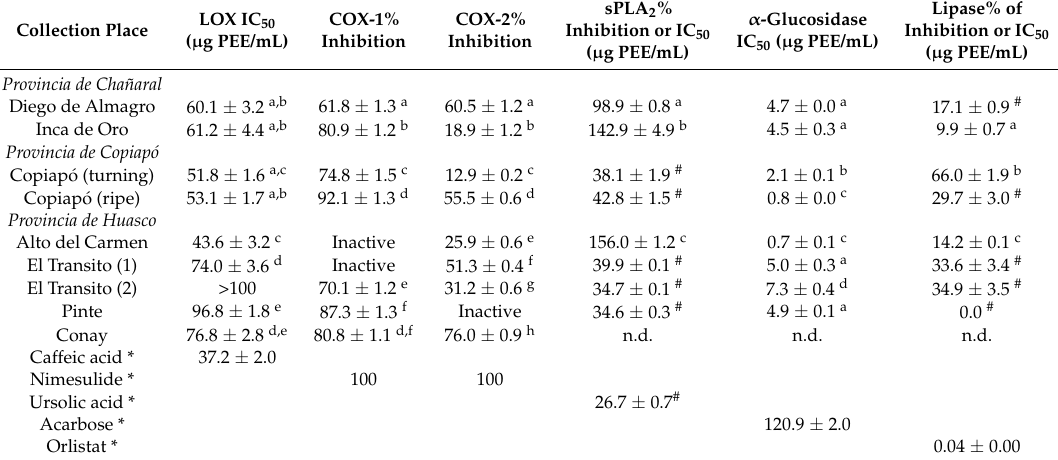
Table 2. Inhibition of the pro-inflammatory enzymes (LOX, COX-1/COX-2 and sPLA 2 ) and metabolic syndrome-associated enzymes ( α -glucosidase and lipase) by G. decorticans fruit PEEs. Data are reported as IC 50 values or % inhibition (at 50 µ g/mL for COX-1/ COX-2, 200 µ g/mL for PLA 2 and 100 µ g/mL for